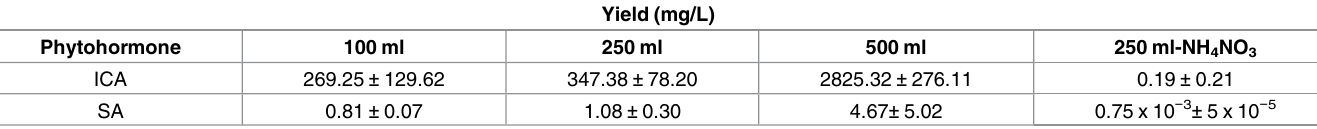
Table 1. Averageconcentrations of plant secondary metabolites, indole-3-carboxylic acid (ICA) and salicylic acid (SA) in the culture medium of L . theobromae strain 2334. Culturefiltrate was obtainedafter 9 days of growth in medium containing KNO 3 as nitrogensource and cultivatedas surface culture of different volumes: 100 mL, 250 mL and 500 mL. An additionalexperiment was performed as surface culture of 250 mL using medium with NH 4 NO 3 as nitro- gen source (250 ml-NH 4 NO 3 ). Data are means ± standarddeviationsof three replicates. Detection limit for SA was 1x10 -4 mg/L at a signalto noise ratio of